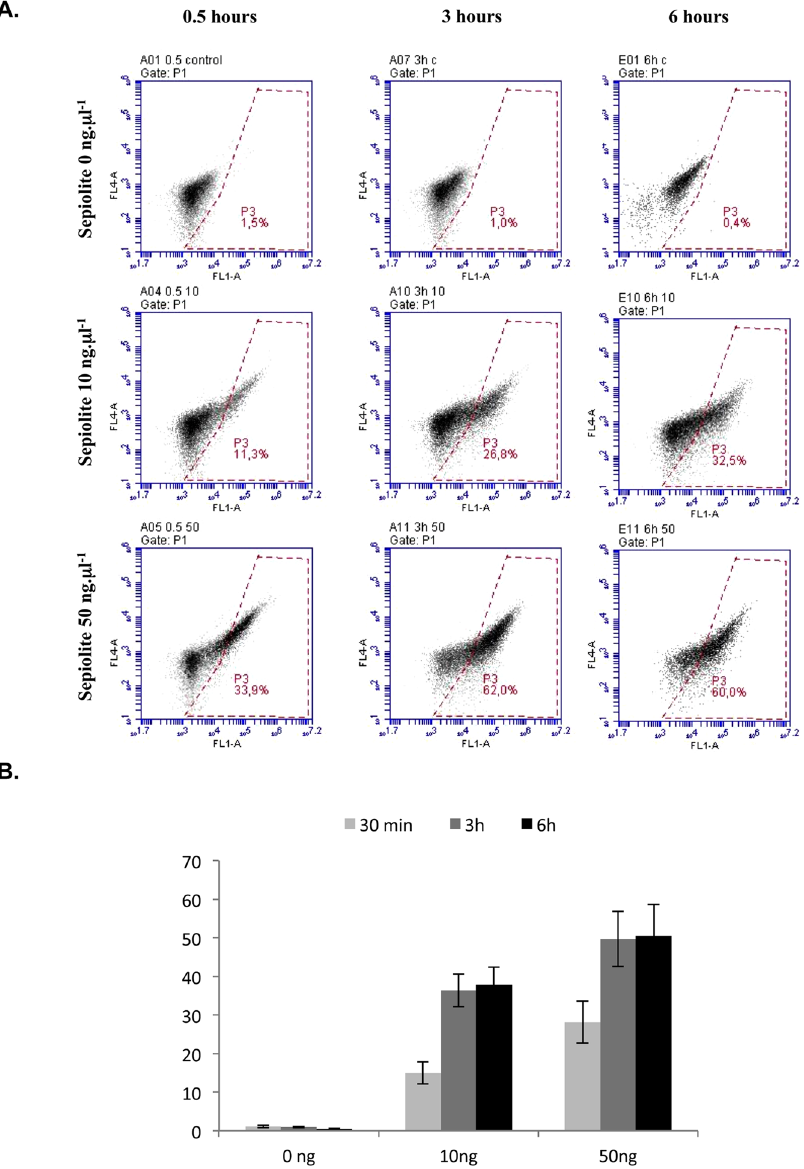
Figure 2. FACS analysis of sepiolite interaction with V79 cells. ( A ) FACS analysis, 0.5, 3 and 6 hours after the addition of sepiolite into V79 cells at different concentrations (0 ng· μ L − 1 , 10 ng· μ L − 1 , and 50 ng· μ L − 1 ). The zone P3 corresponds to green fluorescent cells (channel FL1A, 530 nm) from the presence of sepiolite into the cell. 10 000 cells were counted in all experiments. ( B ) Quantification of sepiolite/cell interactions. Values represent the mean + / − SEM of 6 independent